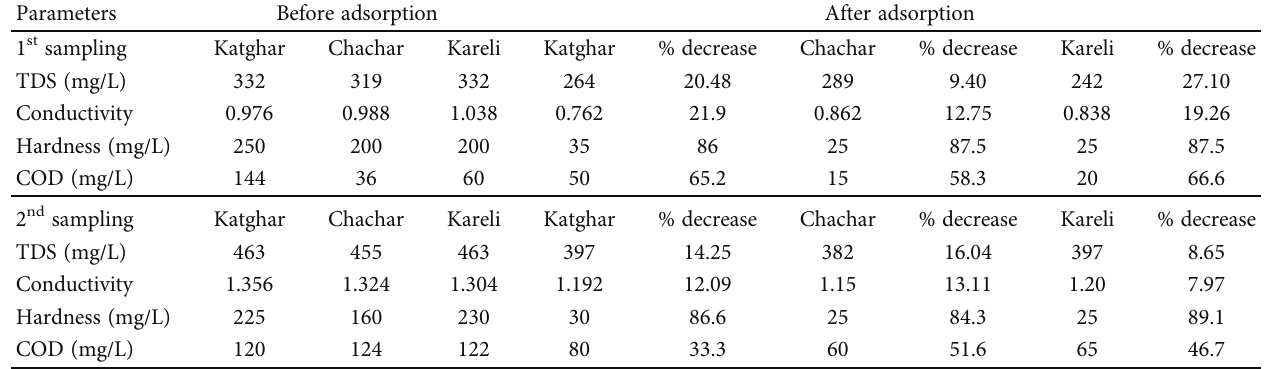
Table 3: Adsorption e ff ect of Neolamarckia cadamba leaves on water quality parameters of three locations of Yamuna River. Parameters